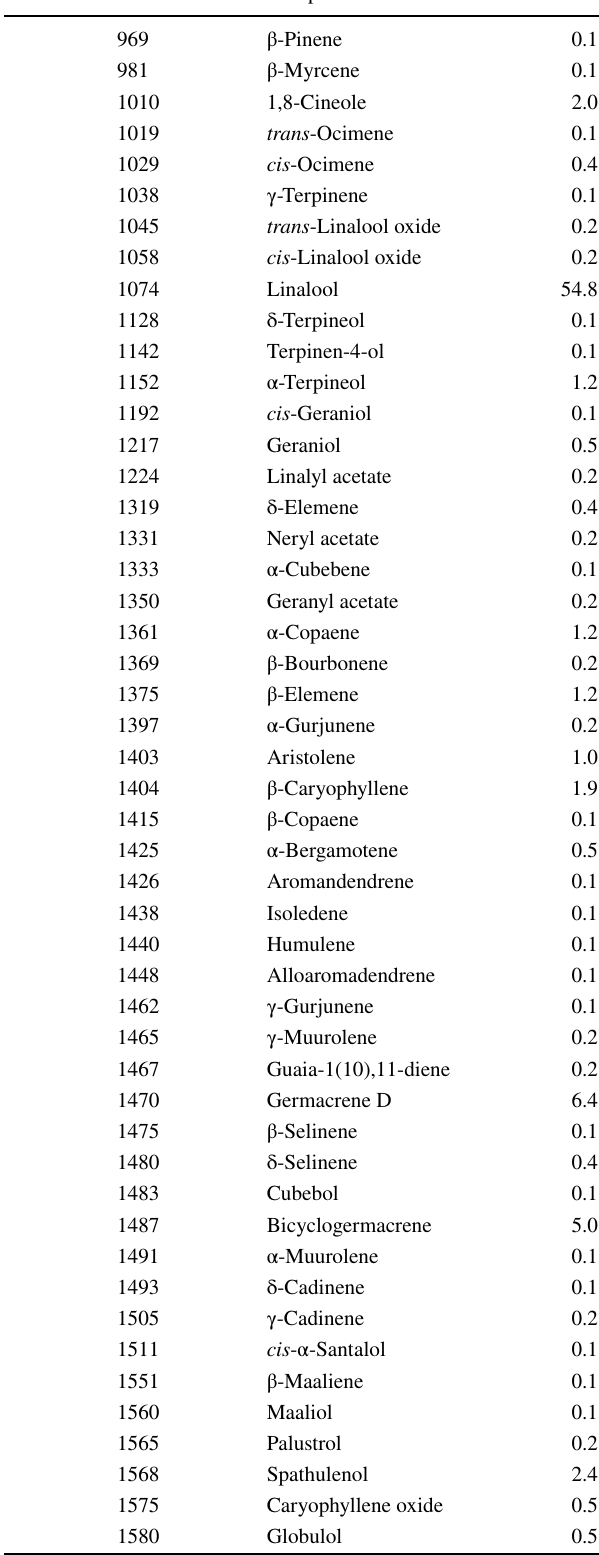
Table 1 Composition of Salvia ceratophylla L . essential oil from Dana Biosphere Reserve, South